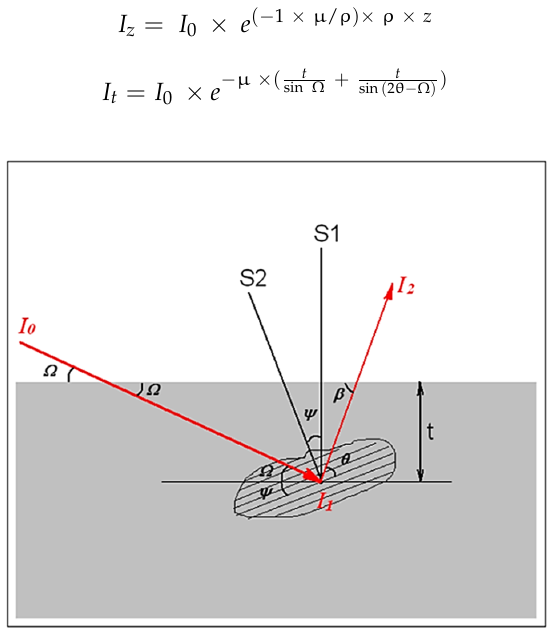
Figure 9. A schematic sketch showing mass attenuation of X ‐ ray in a diffraction process.